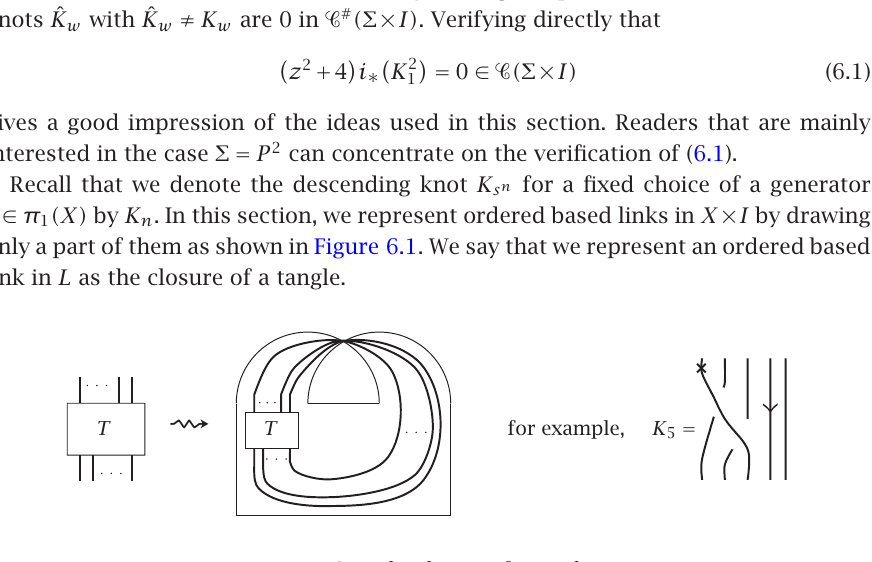
Figure 6.1 . The closure of a